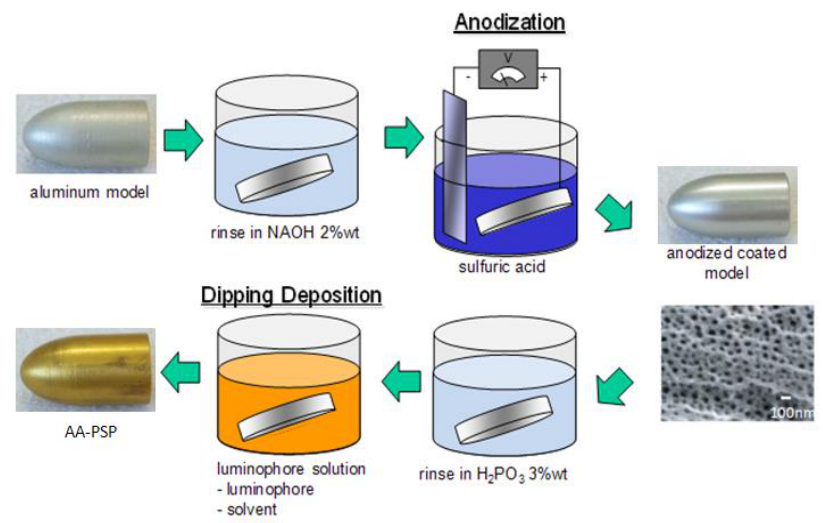
Figure 2. Schematic of the test model preparation.